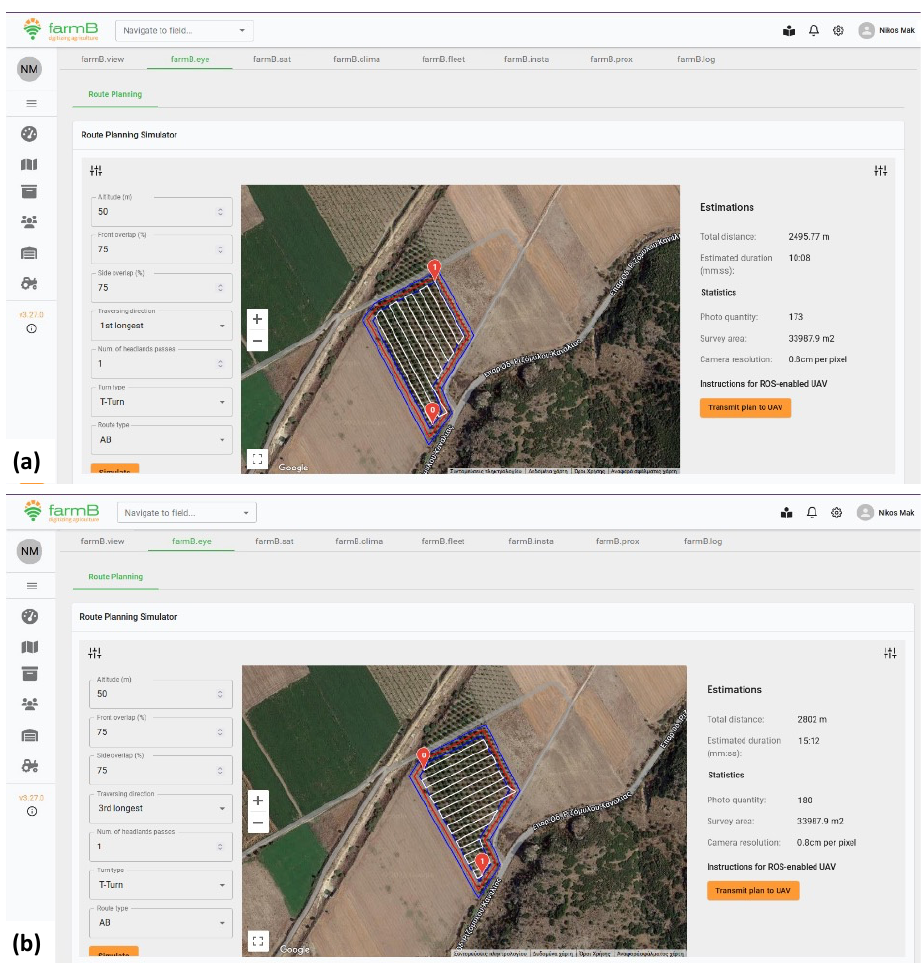
Figure 3. The FMIS digital platform interface for the generation of the UAV area coverage plans: ( a ) UGV’s track’s direction parallel to the longest side of the orchard; ( b ) UGV’s path orientation vertical to the longest side of the orchard.